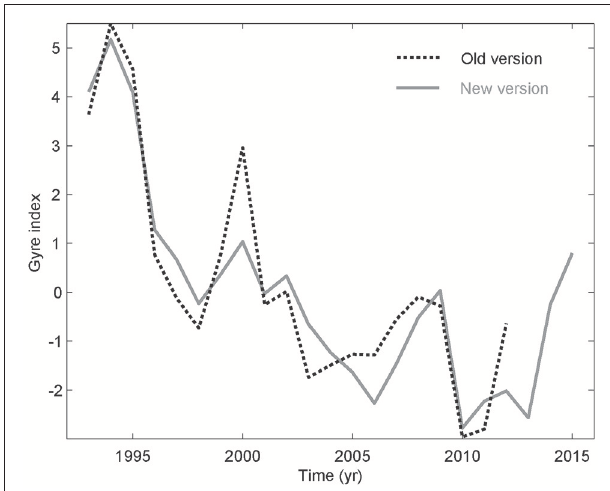
FIGURE 2 | Altimetry-based gyre indices, calculated from the new (gray) and the old AVISO data versions (dashed, Larsen et al., 2012),